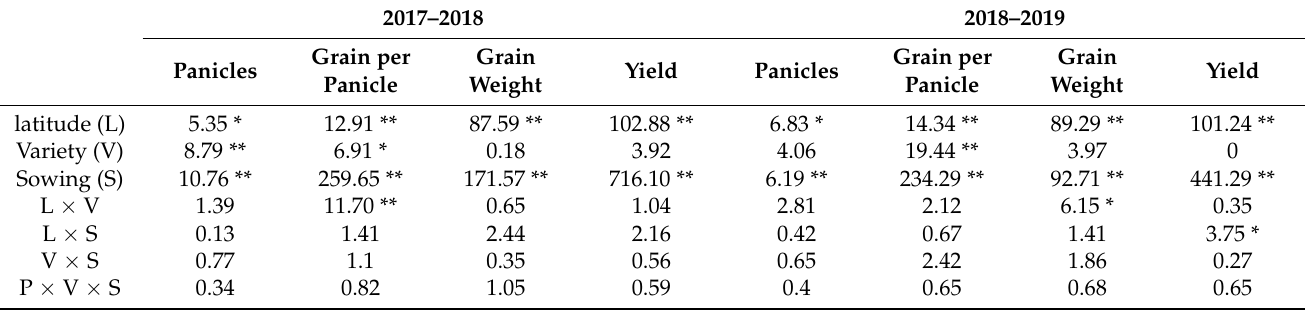
Table 6. Correlation between experimental point, sowing date and yield components (F value).